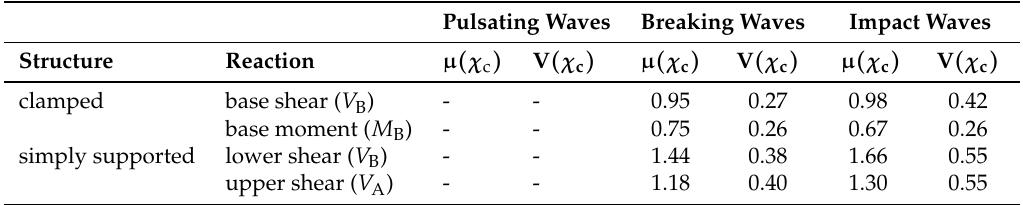
Table 4. Mean ( µ ) and coefficient of variation (V) of the model uncertainties in GT wave load formula caused by differences in dynamic behavior between slender hydraulic structures and caisson structures. Model uncertainty defined by Equation